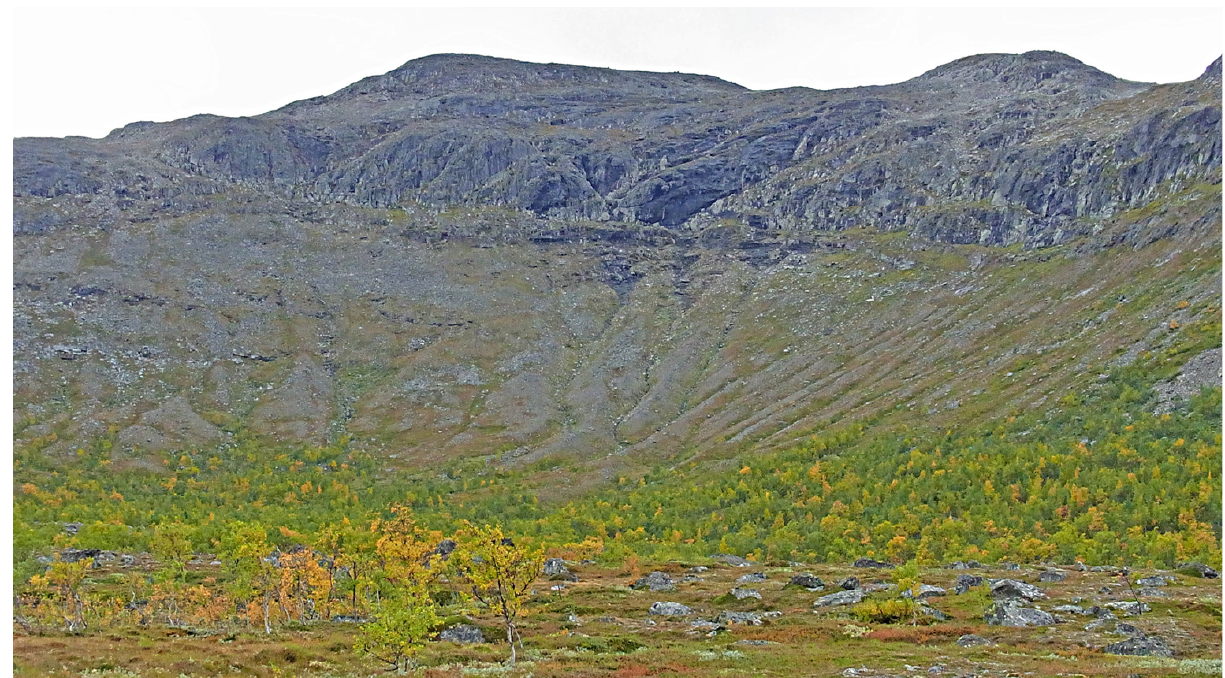
Figure 45: The empty glacier cirque of Mt. Lillstensdalsfjället. Dense birch stands and some pines prevail in the lower slopes, while scattered trees prosper at favourable spots at much higher elevations, above the scree slopes. This may be an analogue of the situation in many cirques where subfosil wood is witness of early-Holocene tree growth.